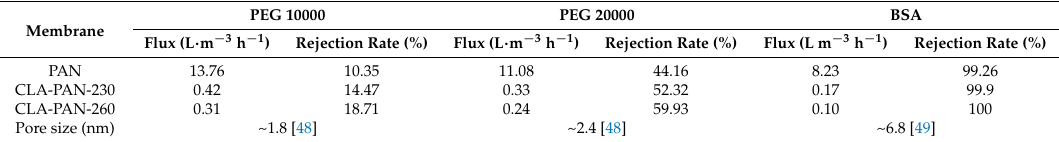
Table 1. Fluxes and rejection rates of PAN membrane, CLA-PAN-230 and CLA-PAN-260 membranes. Membrane